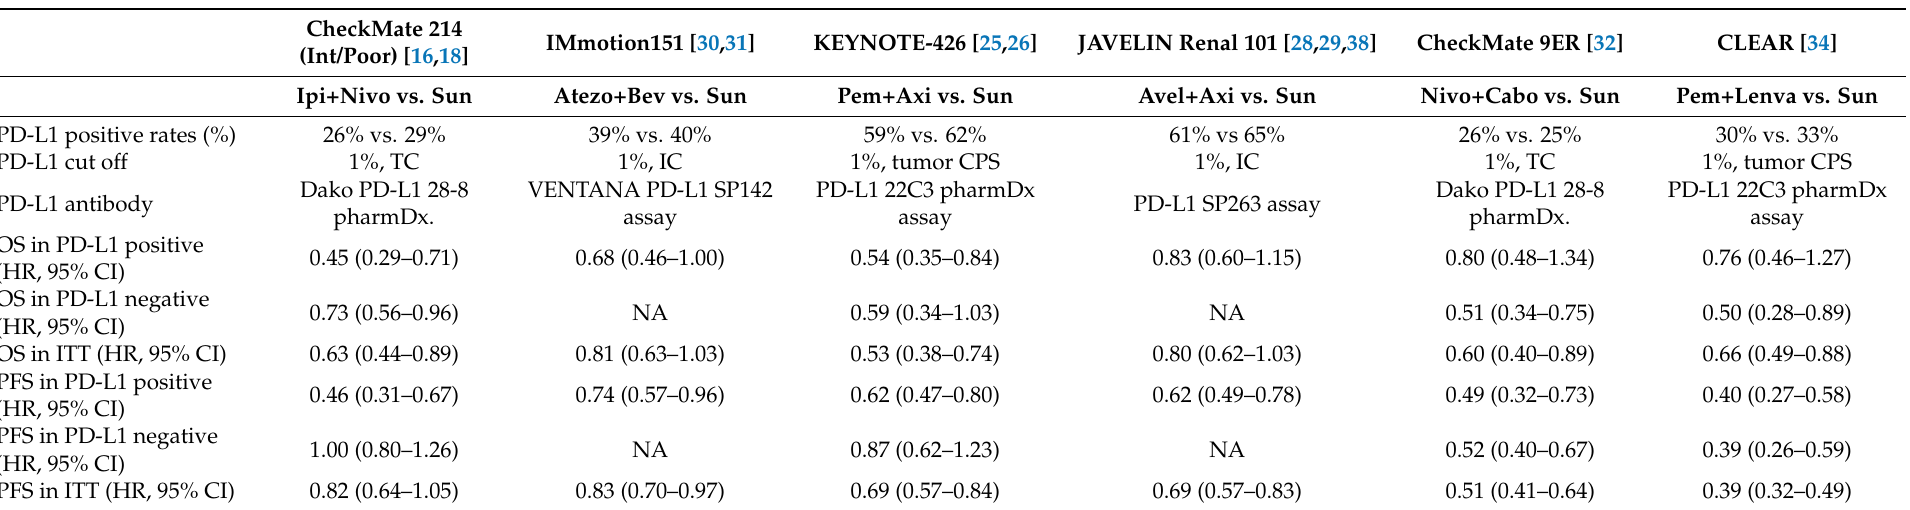
Table 2. Summary of PFS and OS of front-line pivotal trials according to PD-L1